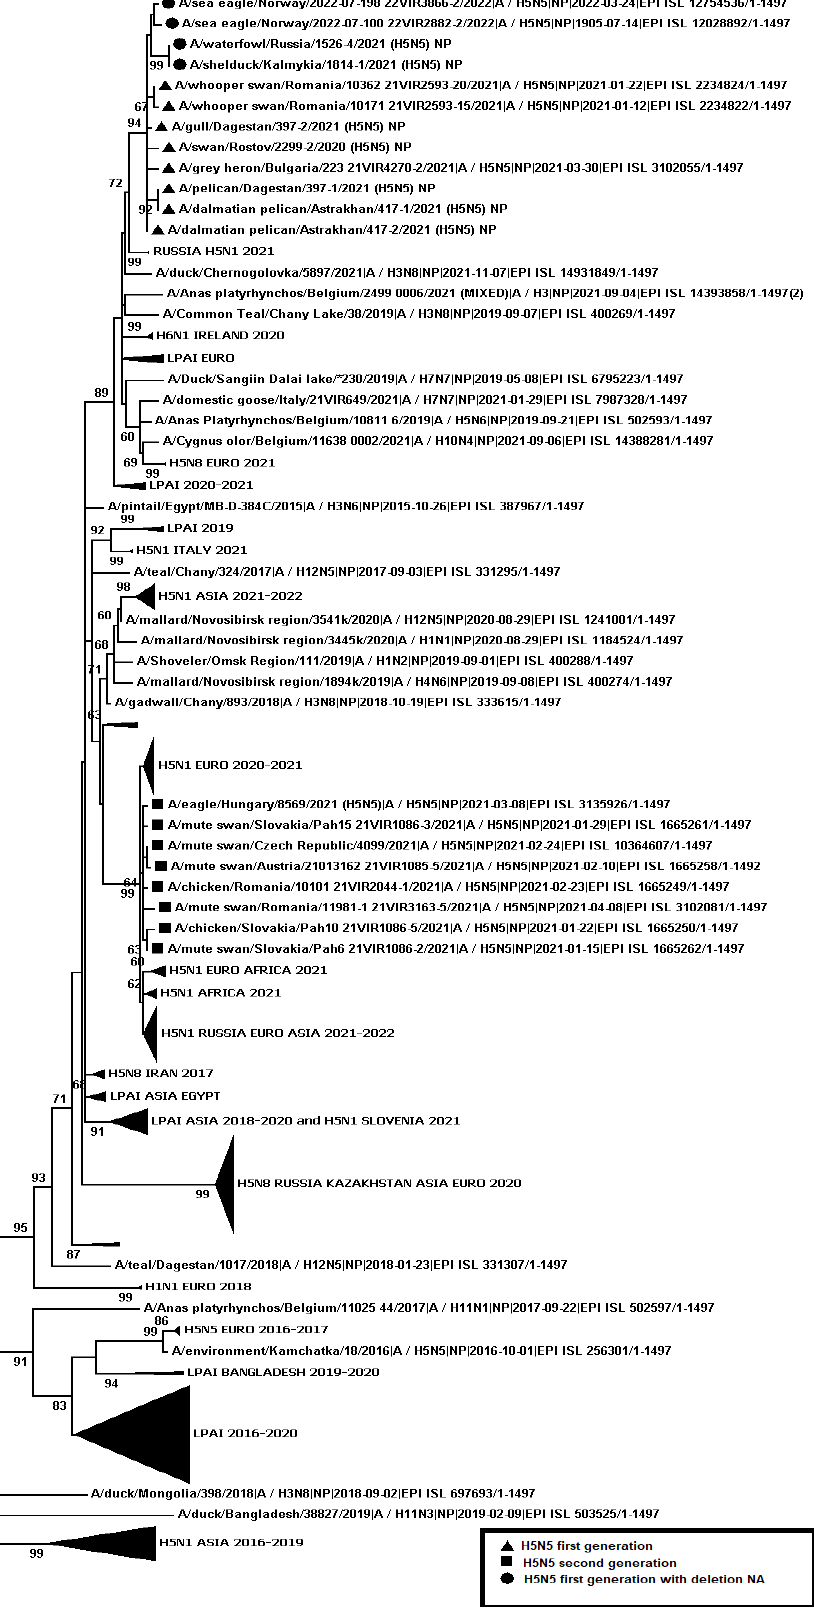
Figure 8. Phylogenetic tree constructed using the NJ method, based on the nucleotide sequence of the NP gene fragment (1–1497 bp ORF) of AIV subtype H5.